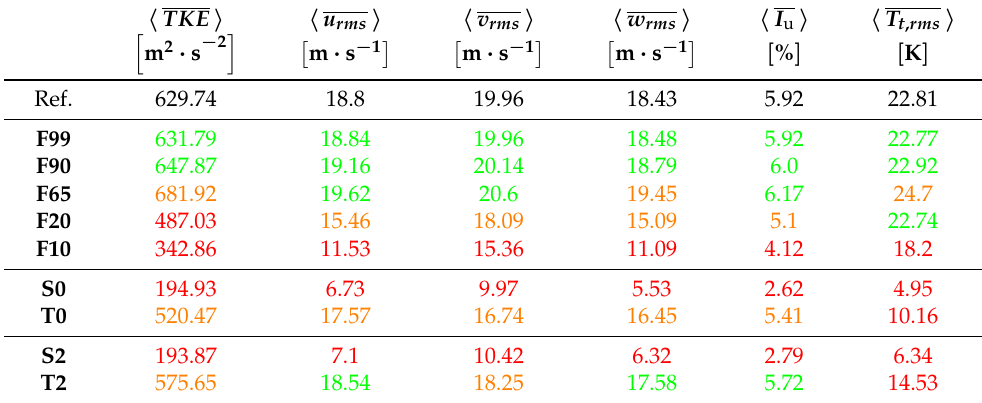
Table 5. Spatial average of TKE, velocity RMS, total temperature RMS, and turbulent intensity at plane 41. The color of the values are determined by their relative difference compared to the reference: Green for relative differences lower than 5%, orange between 5% and 20%, and red for relative differences greater than 20%. The reference corresponds to the integrated combustor/turbine